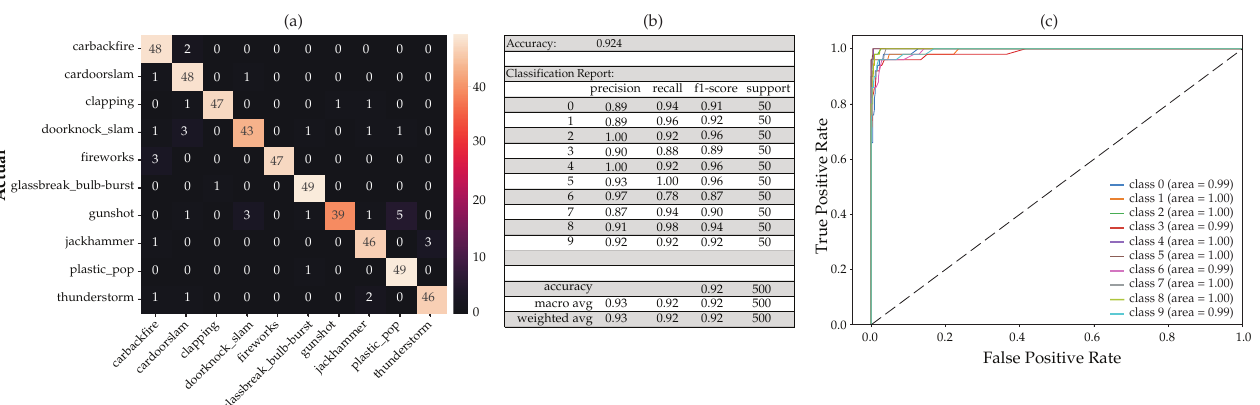
Figure 11. The generated model using only the first 20 features according to the SHAP feature importance analysis, showing the resulting: ( a ) confusion matrix, ( b ) classification report and, ( c ) ROC curves. Table 5. Comparison of the RF MDI and SHAP 20 most important features. MDI SHAP Feature